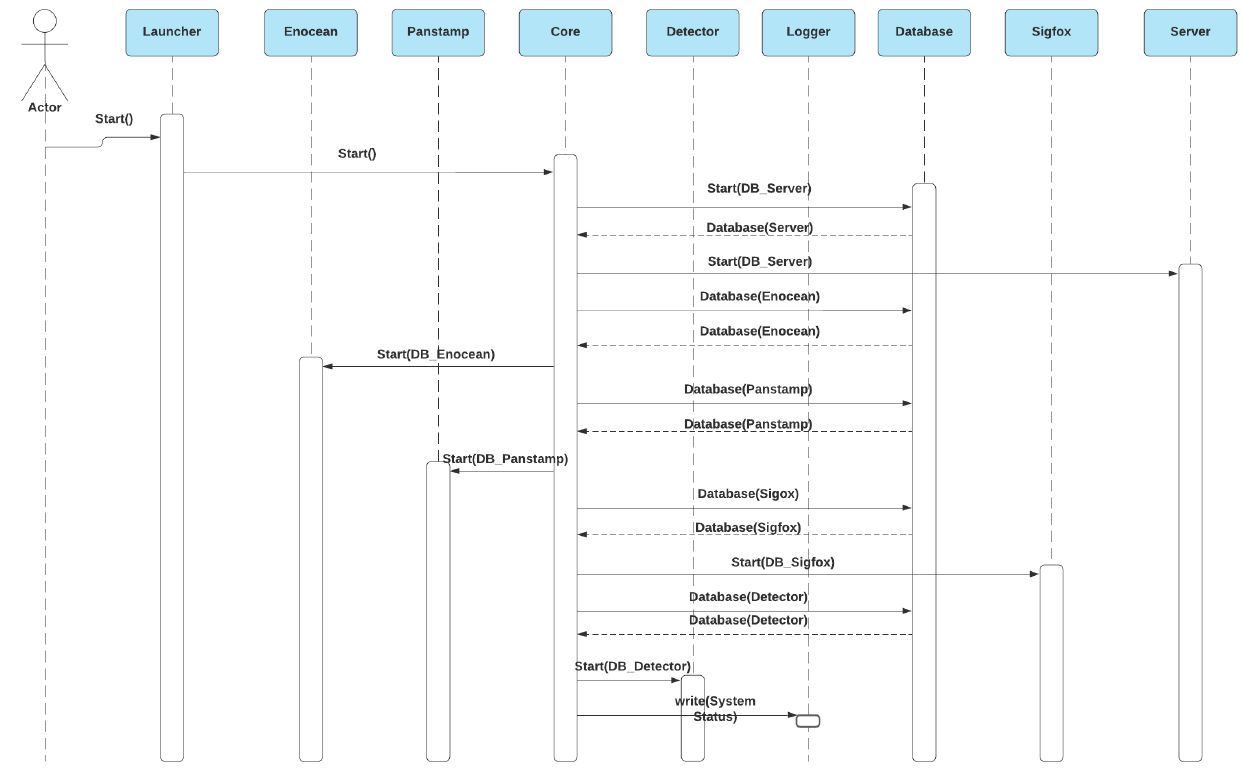
Figure 21. The system startup sequence diagram.